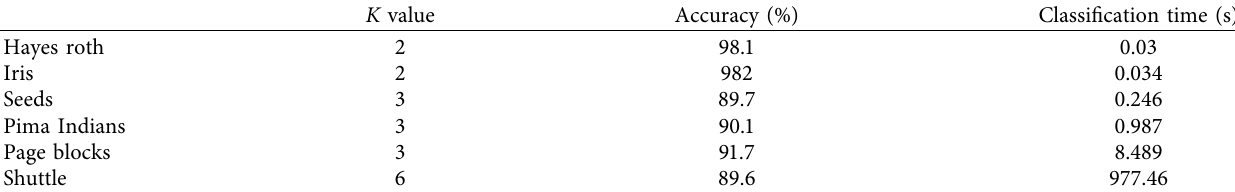
Table 5: The classification results of KNN PK+ .